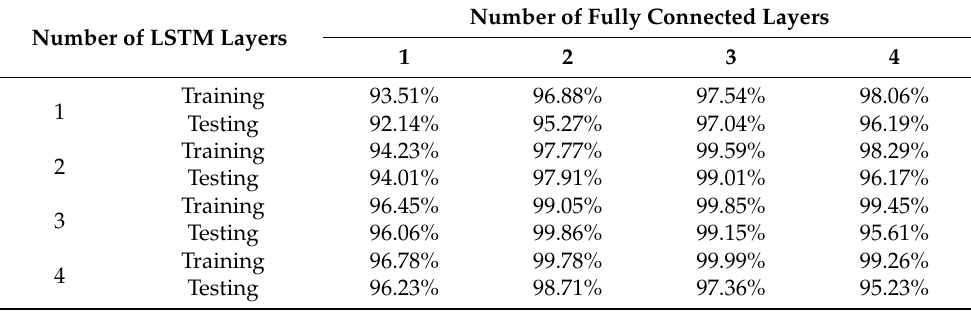
Table 2. Performance of the Proposed IIDS with Different Number of LSTM and FC Layers. Number of Fully Connected Number of LSTM Layers